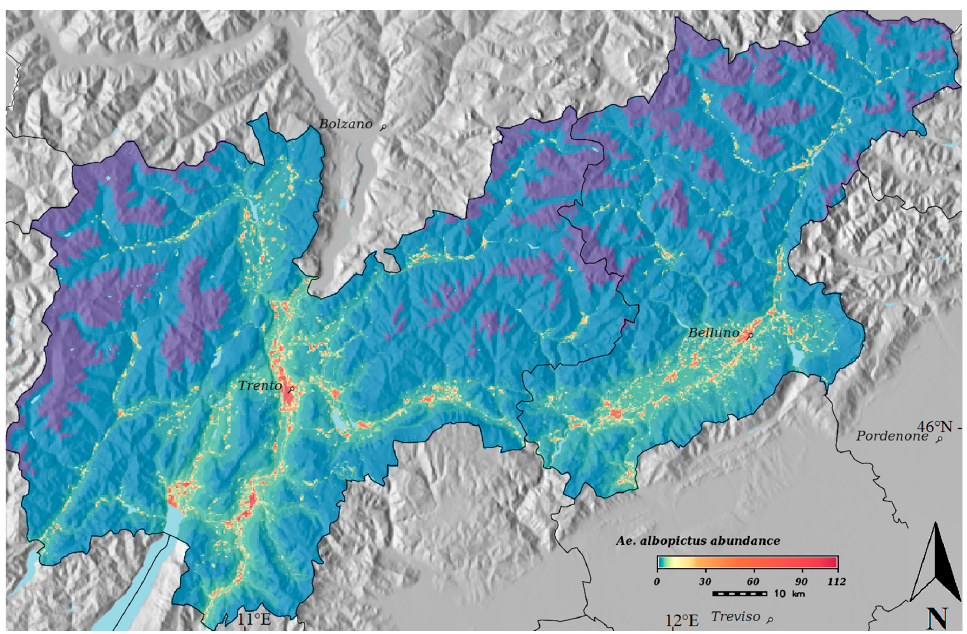
Figure 4. Map (datum: ETRS89 European Terrestrial Reference System; projection: LAEA Lambert Azimuthal Equal Area) of the simulated abundance of Aedes albopictus females (sum of eight trap nights from June to September) in the provinces of Belluno and Trento (Italy) based on the most parsimonious model including the mean temperature of the warmest quarter and the percentage of artificial areas in 250 m pixels as predictors. The colour ranges from purple, corresponding to 0 specimens per trap per year, to red-berry, corresponding to 112 specimens per trap per year.